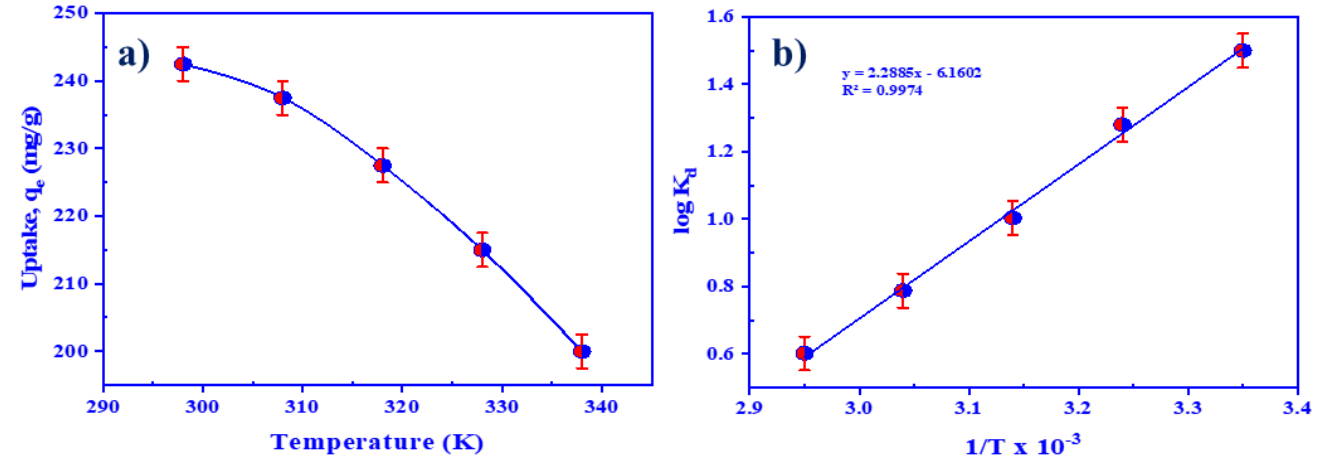
Figure 11. ( a ) The influence of temperature on the retention of uranium by HTIP chelating ligand; ( b ) thermodynamic study of U(VI) ion extraction by HTIP chelating ligand (U(VI) conc.: 0.42 × 10 − 4 mol/L, HTIP/CHCl3 conc.: 0.99 × 10 − 3 mol/L (10 mg/25 mL), pH 3.0, A/O 1:1, time: 30 min).